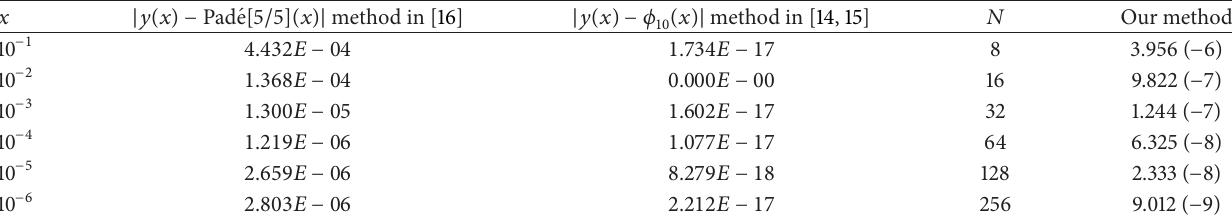
Table 2: The M.A. error in solutions of Example